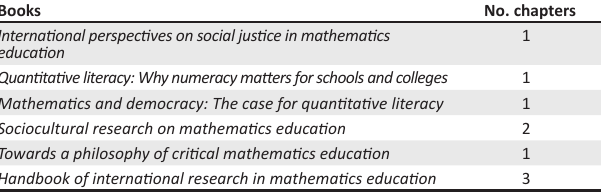
TABLE 3: Overview of the references consulted for the development of the literature review: Layer 3 −